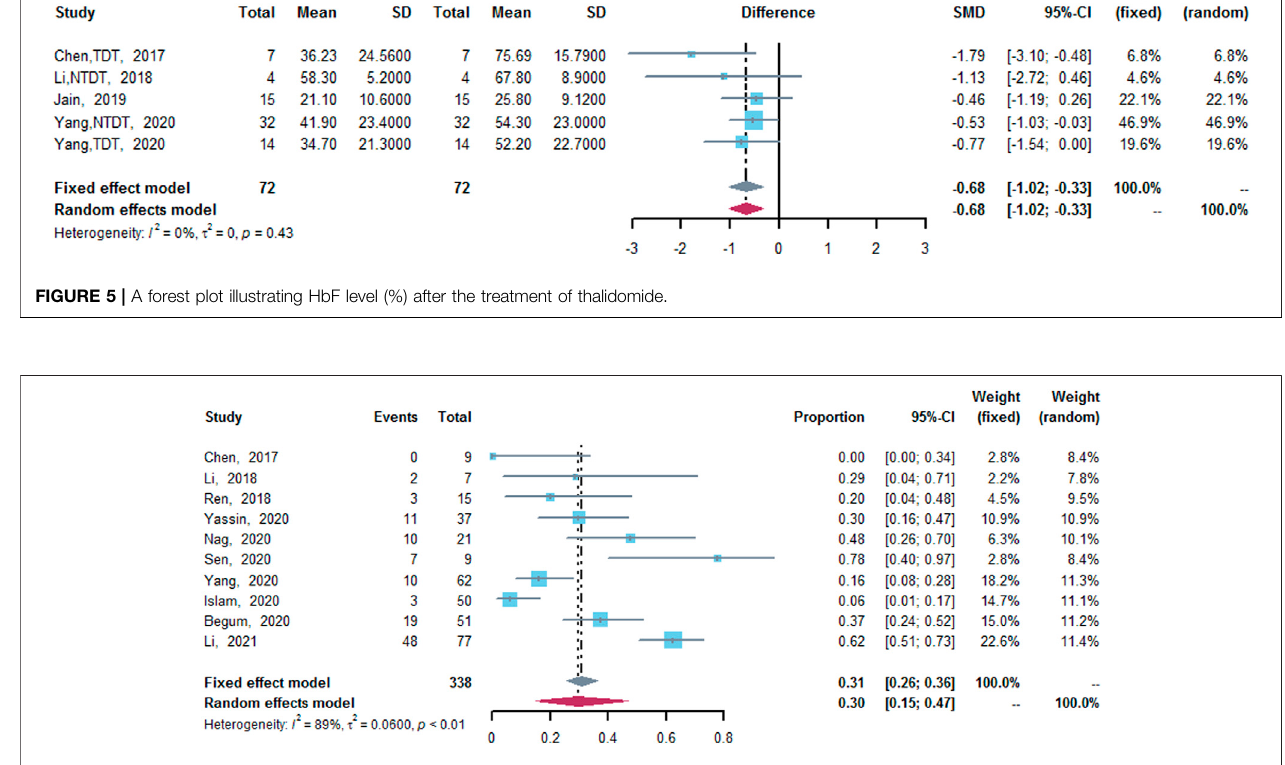
FIGURE 6 | A forest plot illustrating adverse effects of thalidomide.